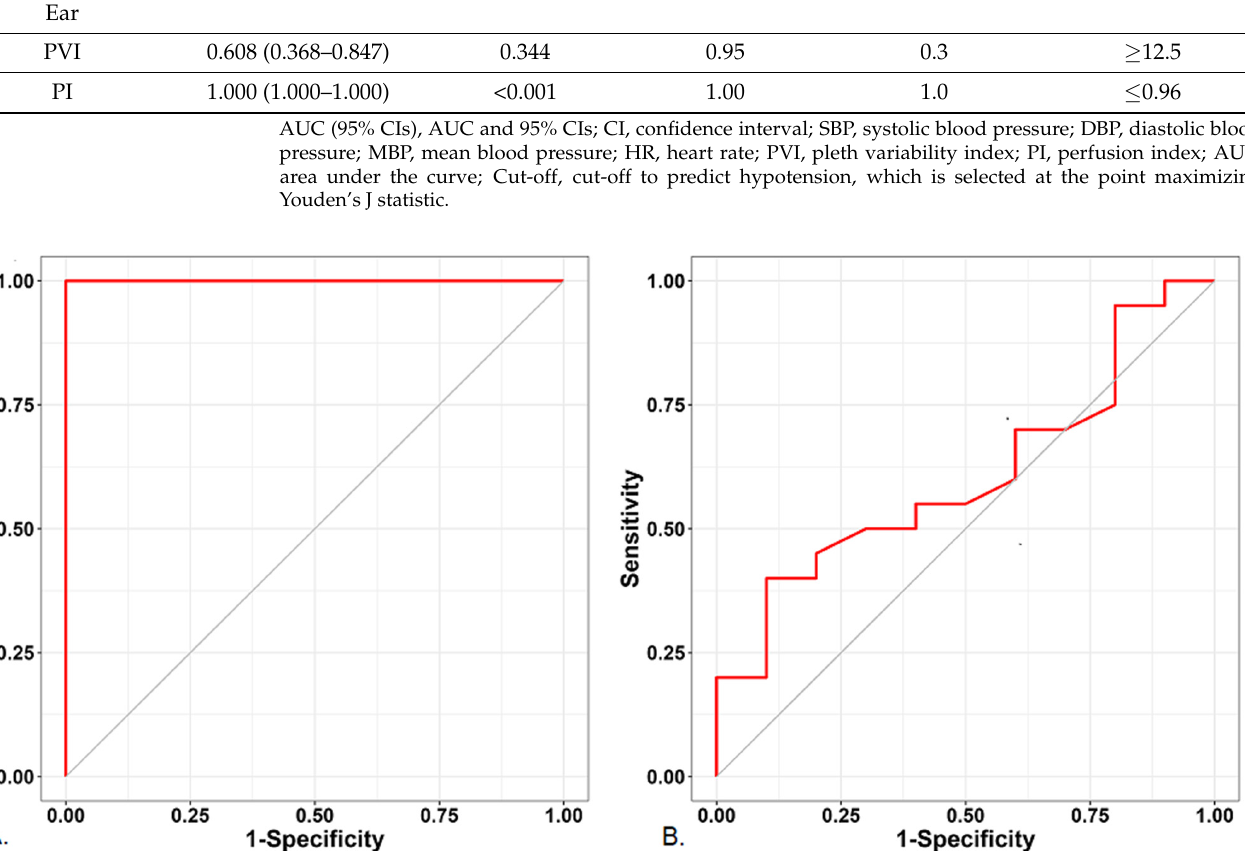
Table 3. Correlation between the lowest SBP and hemodynamic variables measured at baseline.